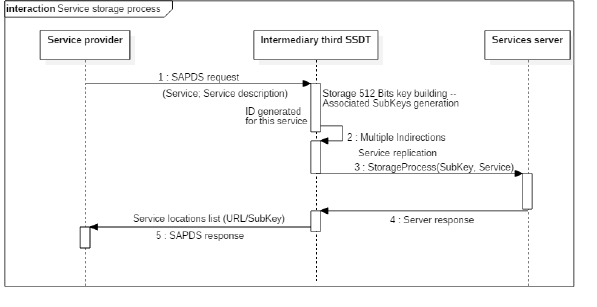
Figure 6. Service Secured